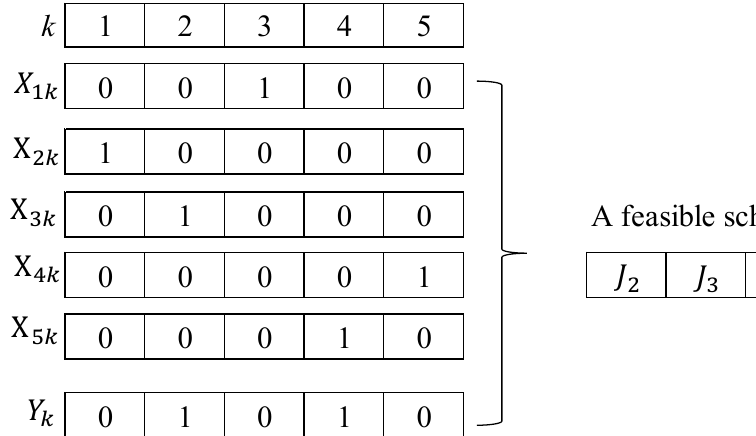
Figure 1. Feasible Figure 1. Feasible schedule.